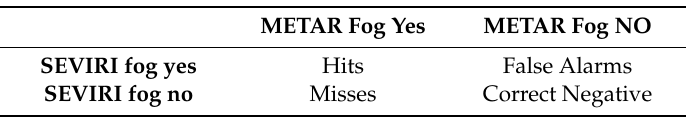
Table 1. Contingency table.